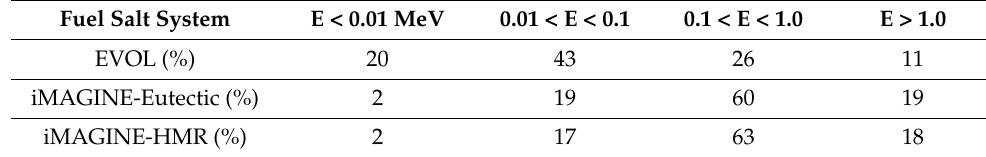
Table 10. Neutron flux-energy spectrum fraction in different energy